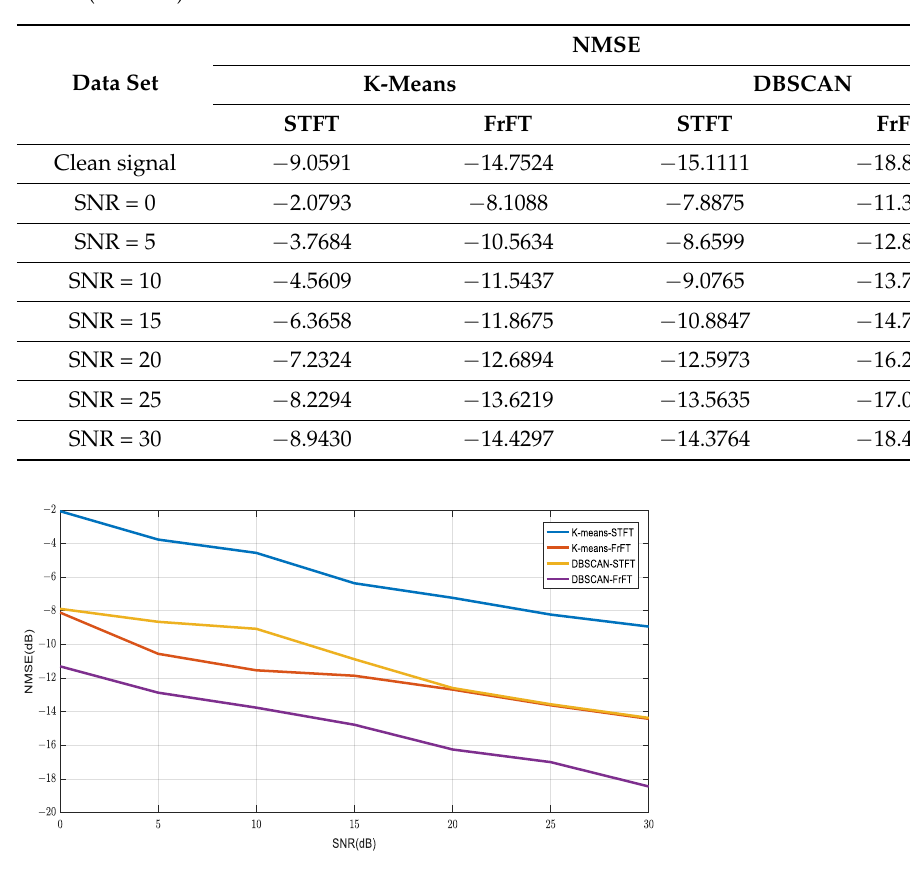
Table 4. Comparison of estimation accuracy of mixed matrix obtained by different clustering algo- rithms (30 times).